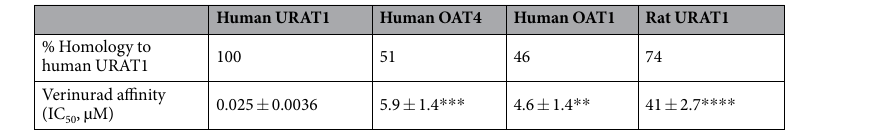
Table 1. Potency of verinurad against human URAT1, human OAT4, human OAT1 and rat URAT1. Values (mean ± SEM) are from at least three dose-response experiments as shown in Fig. 1. Asterisks